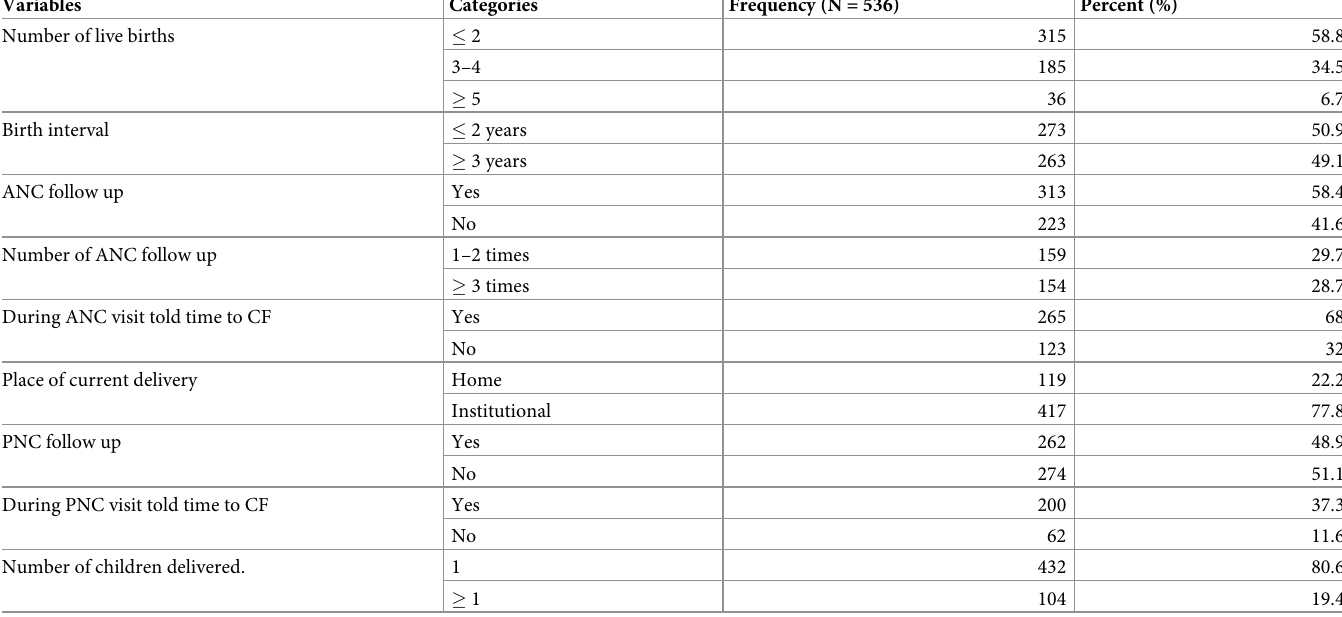
Table 2. Maternal reproductive history and health service utilization of mothers in Farta district, Ethiopia, 2020.